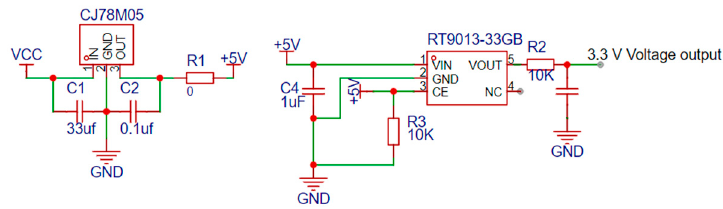
Figure 5. Schematic diagram of power supply circuit.